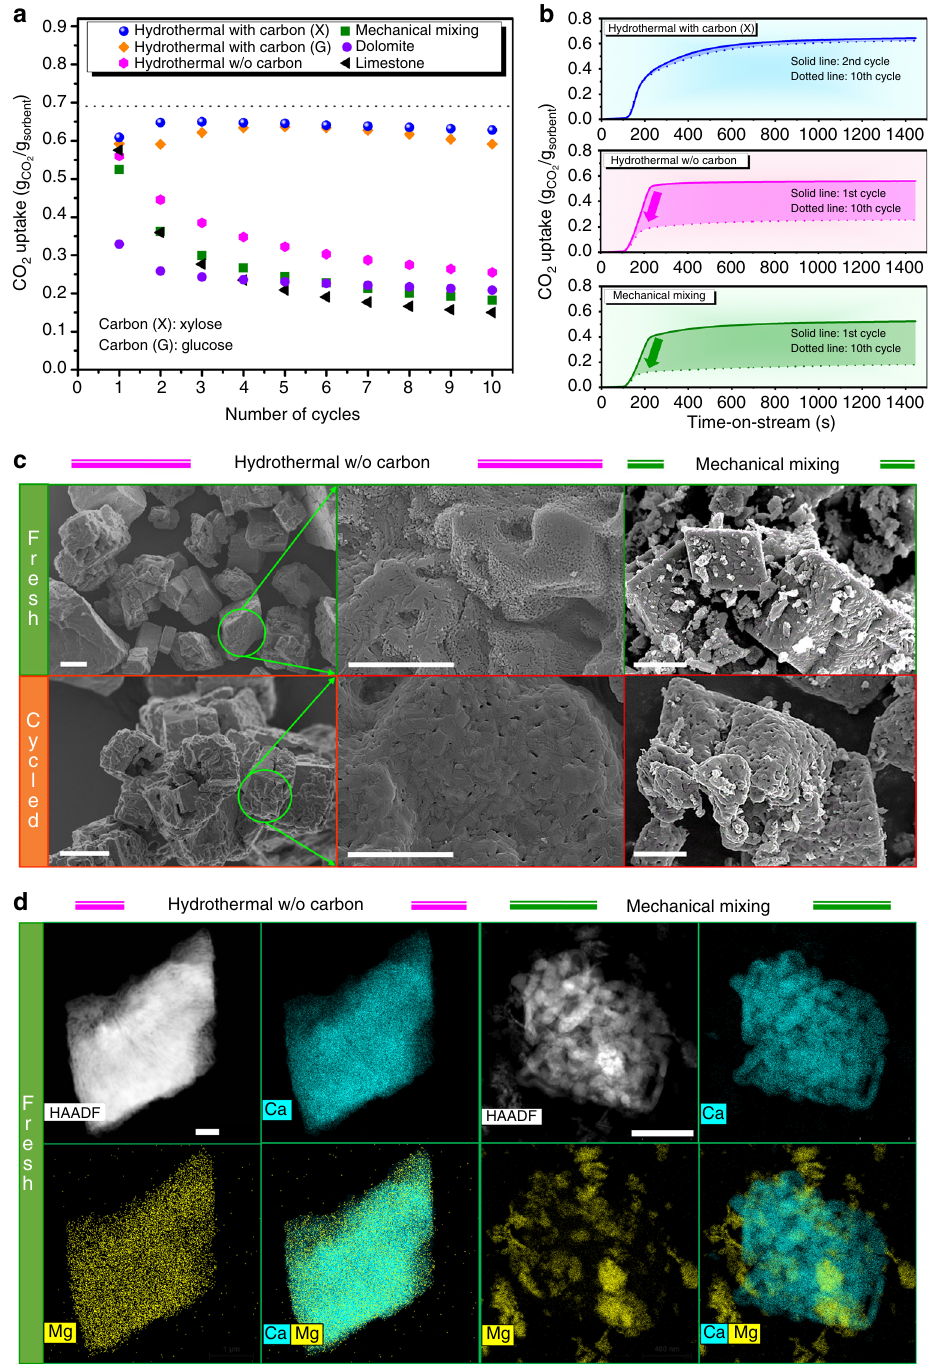
Fig. 7 Effect of the synthesis approach on performance and structure. a CO 2 uptake over ten cycles of calcination and carbonation of CO 2 sorbents that contain a molar ratio of Ca:Mg = 85:15 synthesized by two different approaches: hydrothermal versus mechanical mixing (dotted line represents the maximum theoretical CO 2 uptake of Ca85Mg15). b Temporally resolved carbonation pro fi les of the sorbents with the highest and lowest CO 2 uptakes. c , d SEM images of the as-synthesized and cycled materials, and HAADF-STEM image and EDX mapping of the as-synthesized materials prepared by a hydrothermal route in the absence of a carbon precursor and by mechanical mixing of CaCO 3 and MgCO 3 . Scale bars in c : 20 μ m for the 1st column and 2 μ m for the 2nd and 3rd columns, respectively. Scale bars: 500 nm in